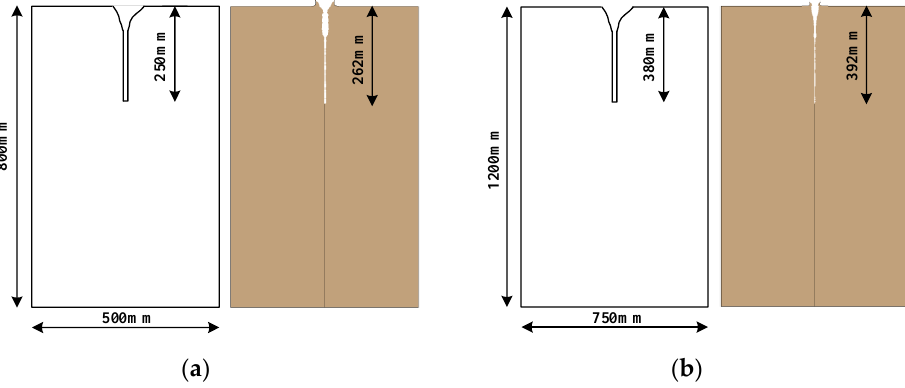
Figure 9. Sizes of shaped charges with different liner angles (unit: mm): ( a ) 90°; ( b ) 150°.